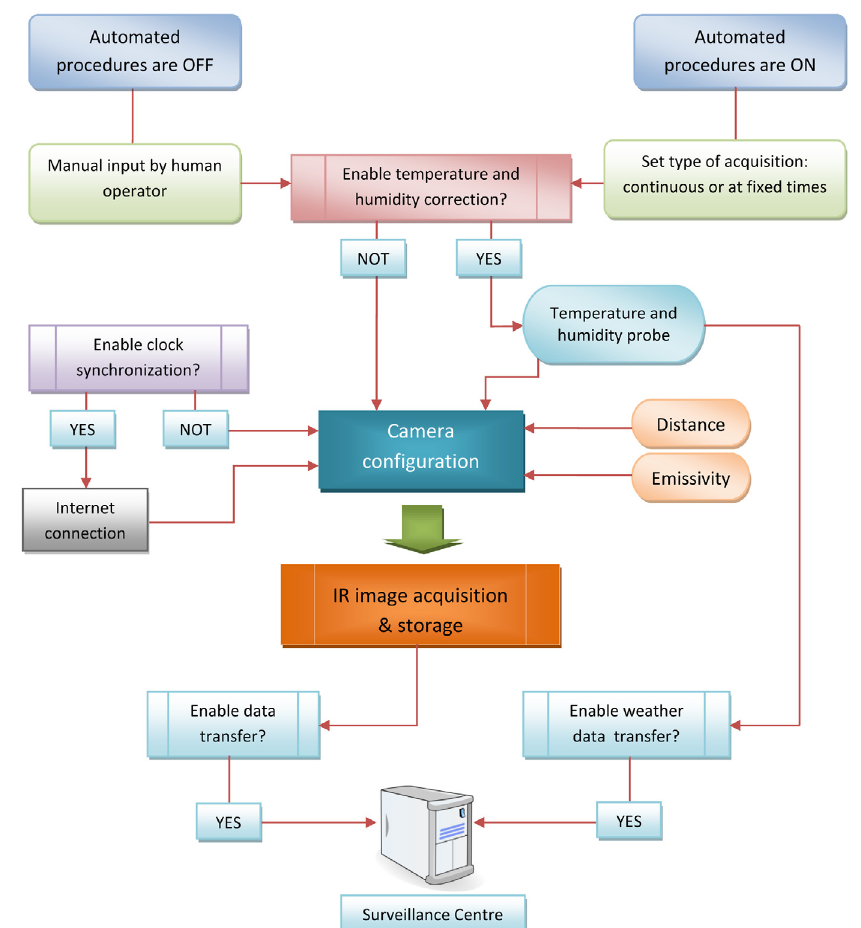
Figure 3. Flow-chart of ICARO station’s main procedures.